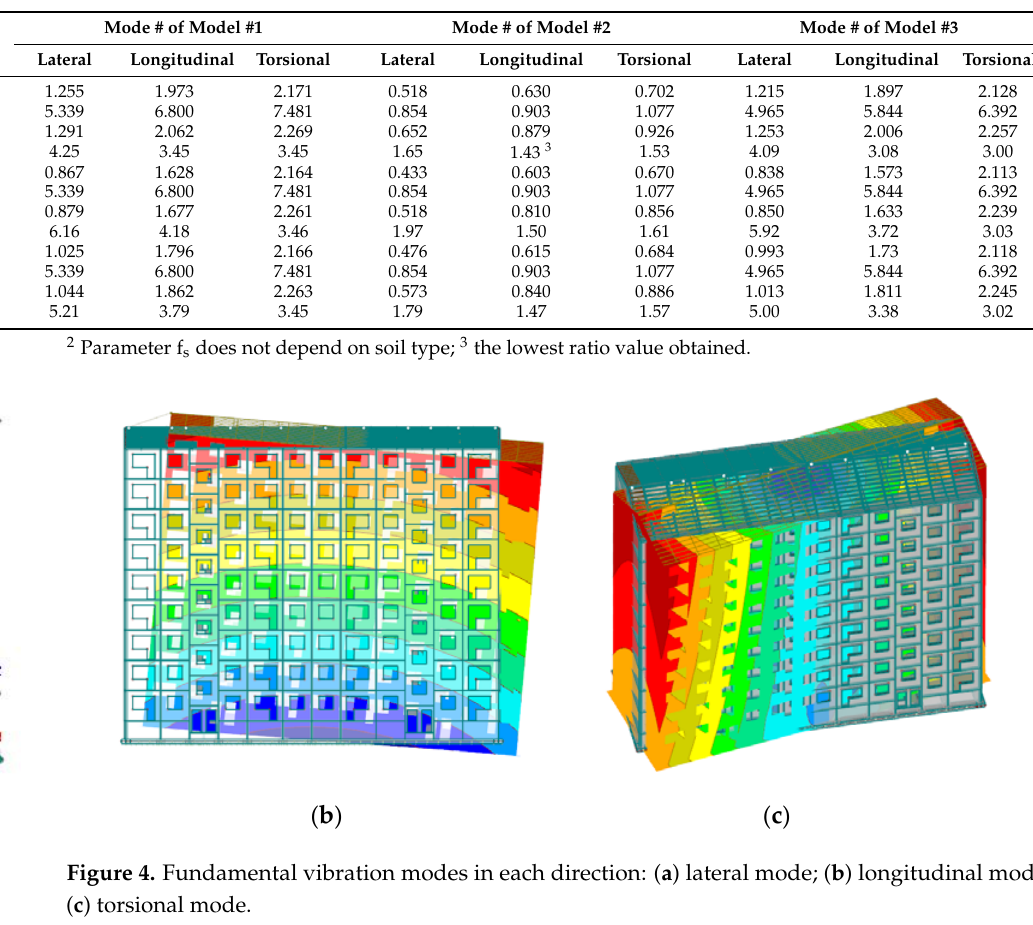
Table 6 summarizes the results obtained from the finite element calculations, decom- posing separately the contribution of each modal component using Equation (2) for the three vibration modes (Figure 4) and showing the ratio between structural mode and the mode with SSI effects including f s /f 1 . Table 6. Structural frequencies and their modal components for building reference models.